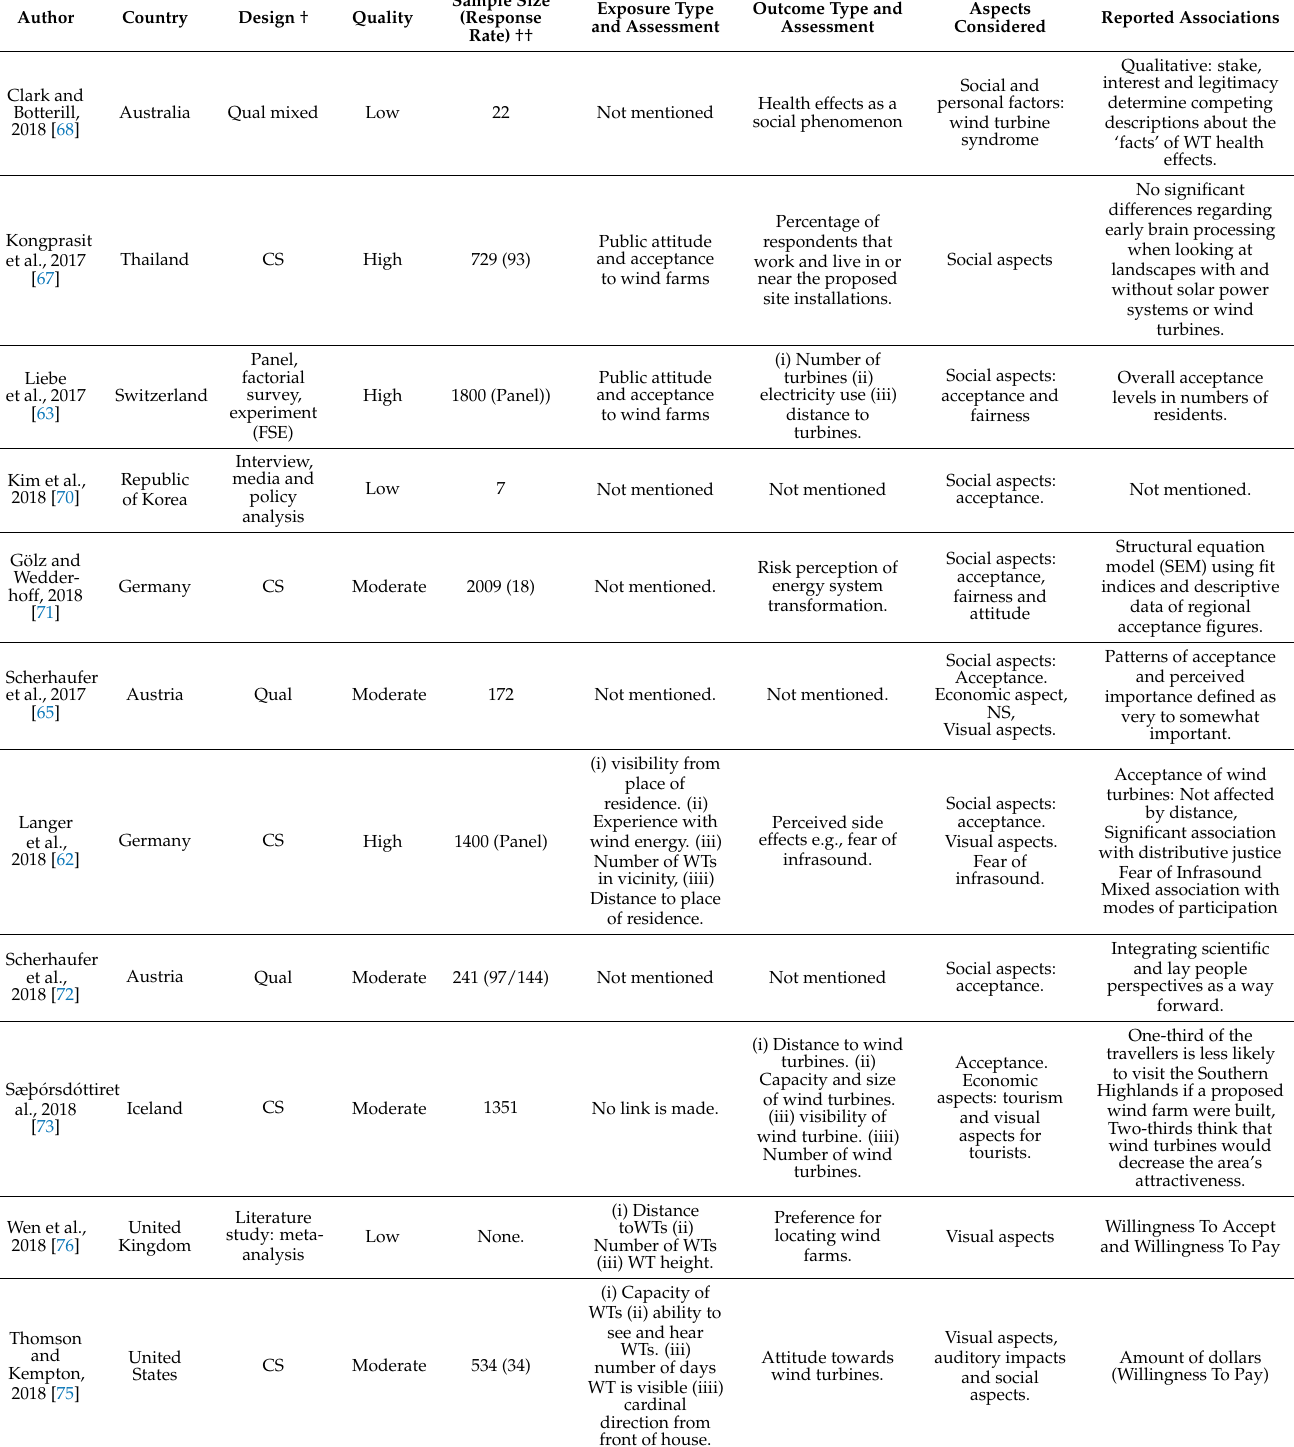
Table 7. Overview of the characteristics of the selected studies on WT sound and physical, social and personal